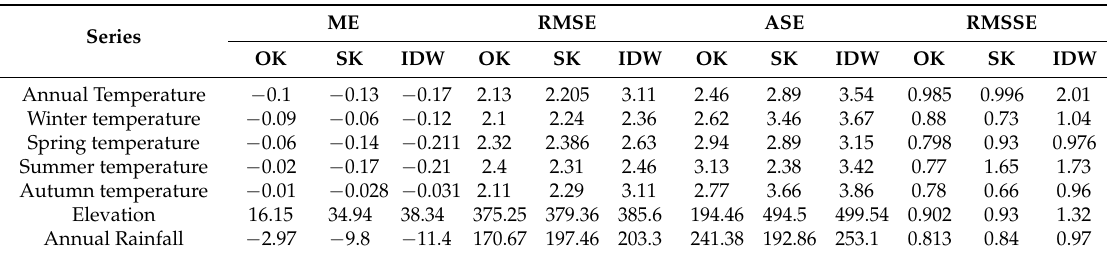
Table 2. The cross-validation of estimated series.